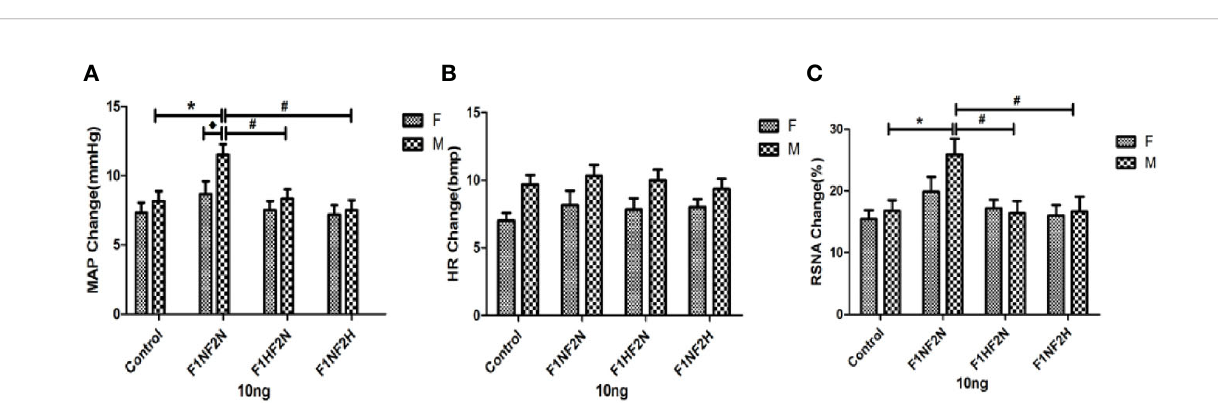
FIGURE 2 | Microinjection of Ang II 10 ng into the LVs in both male and female offspring. Summary data showing the peak effect of Ang II (10 ng, 5 m L) microinjected into LVs on MAP (A) , HR (B) , and RSNA (C) . Data are mean ± SE ( n = 8). * P < 0.05 compared with control, # P < 0.05 compared with F 1N F 2N , and ◆ P <0.05 male F 1N F 2N compared with female F 1N F 2N